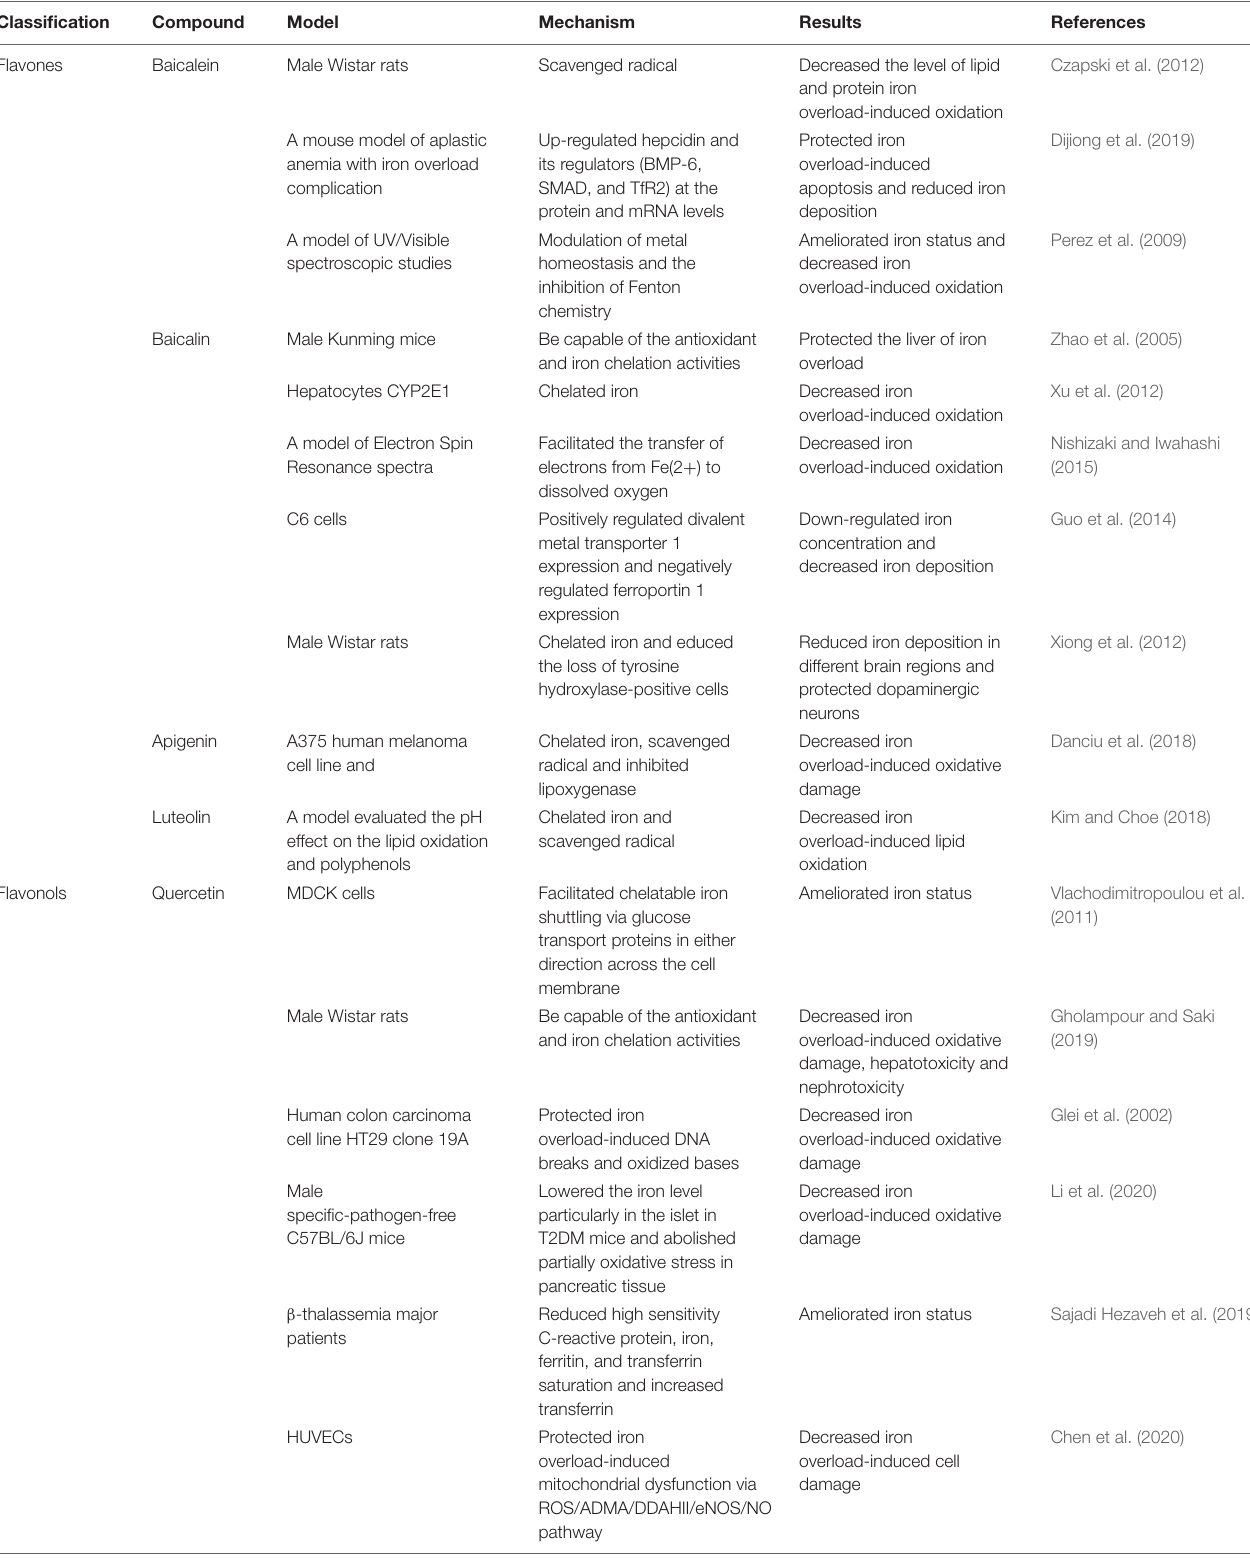
TABLE 3 | Progress in the research regarding flavonoids for the treatment of iron